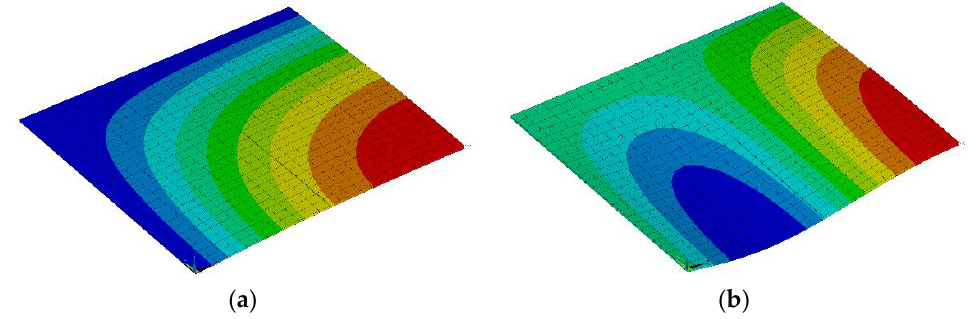
Figure 9. 1st ( a ) and 2nd ( b ) eigenmodes for the rehabilitated plate’s quarter model.